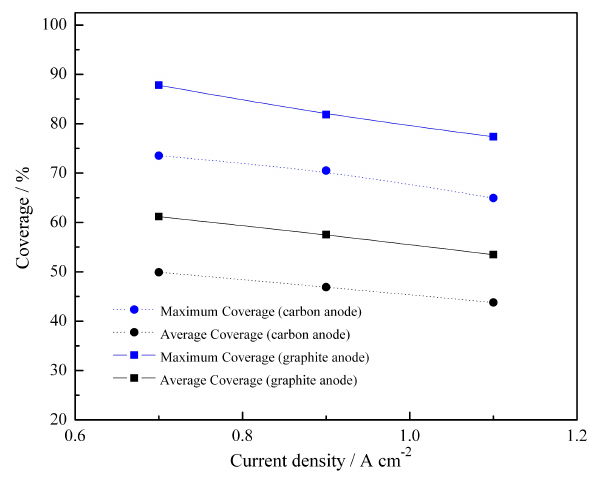
Figure 9. Gas coverage as a function of anodic current density for the carbon and graphite anodes.